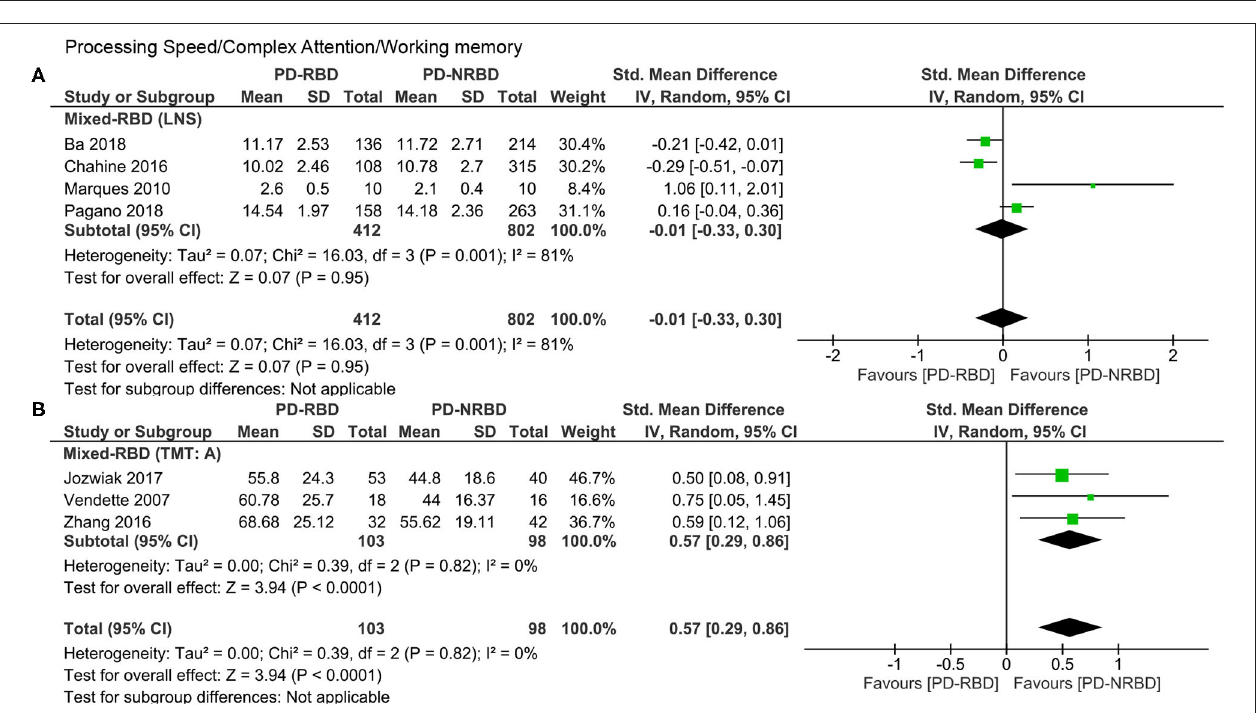
FIGURE 5 | Forest plot for language with subtotals by the diagnosis of rapid eye movement sleep behavior disorder (RBD) displaying effect size calculated using a random-effects model. SD , standard deviation; Std. Mean Difference , standardized mean difference; CI , confidence interval.